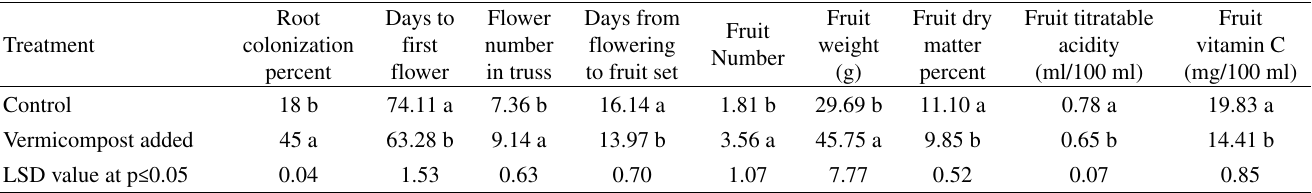
Table 3 - The main effects of vermicompost application on some pepino plant characteristics